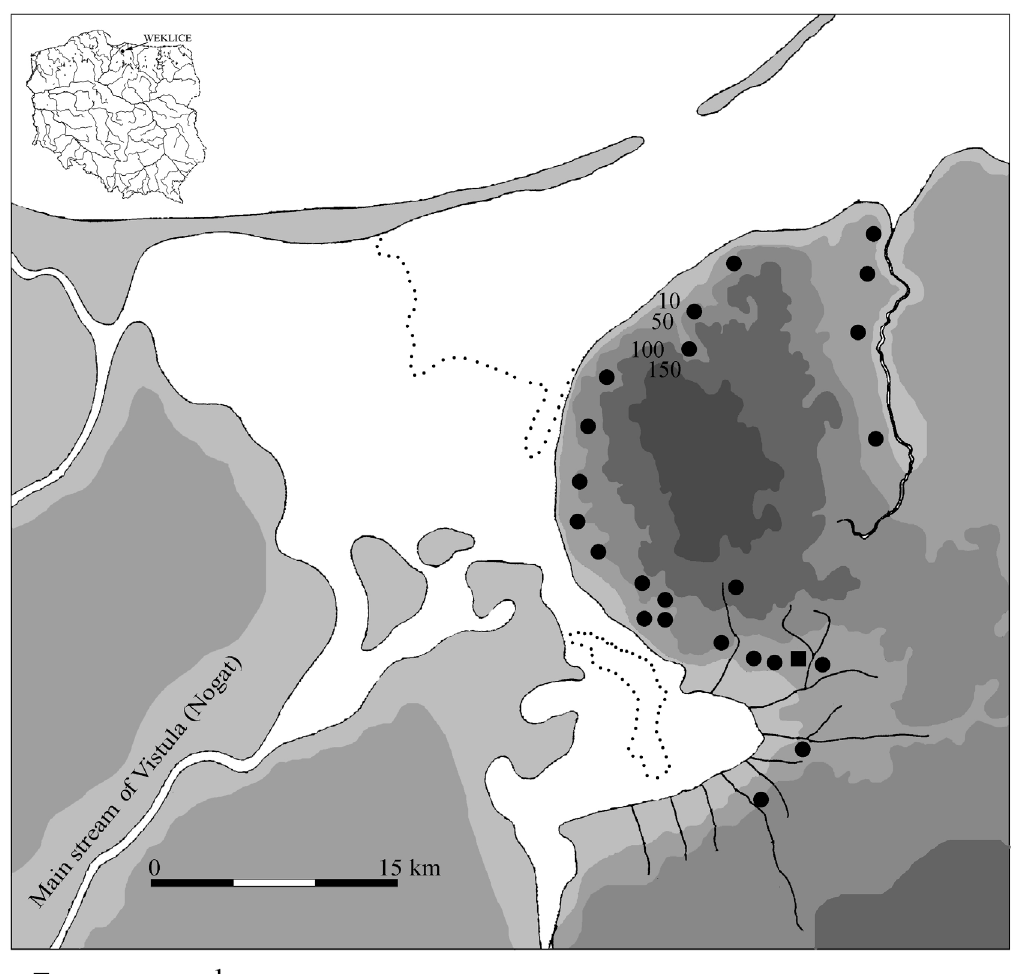
Figure 1. Reconstruction of the Vistula delta during the Roman Period with main sites of the Wielbark culture on the Elbląg Heights: a . location of Weklice cemetery, b. today’s extent of the Vistula Lagoon and Drużno Lake. (Prepared by M. Natuniewicz- Sekuła.